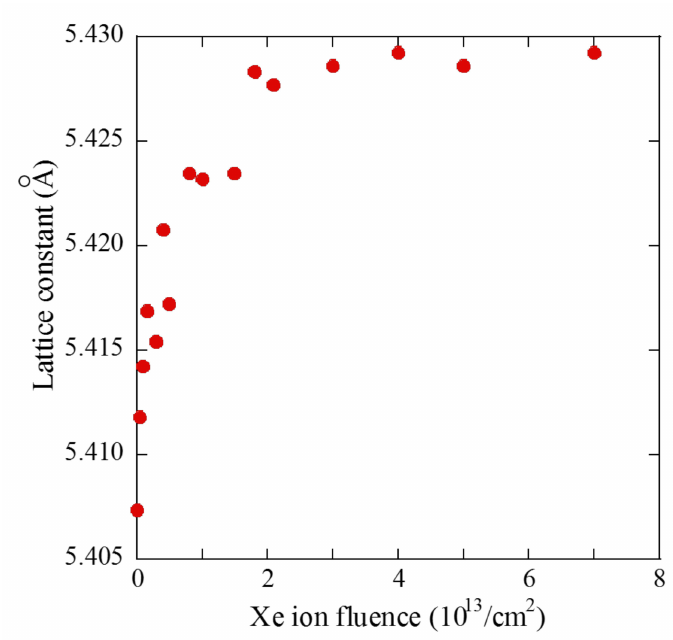
Figure 3. Lattice constant of CeO 2 as a function of Xe ion fluence.